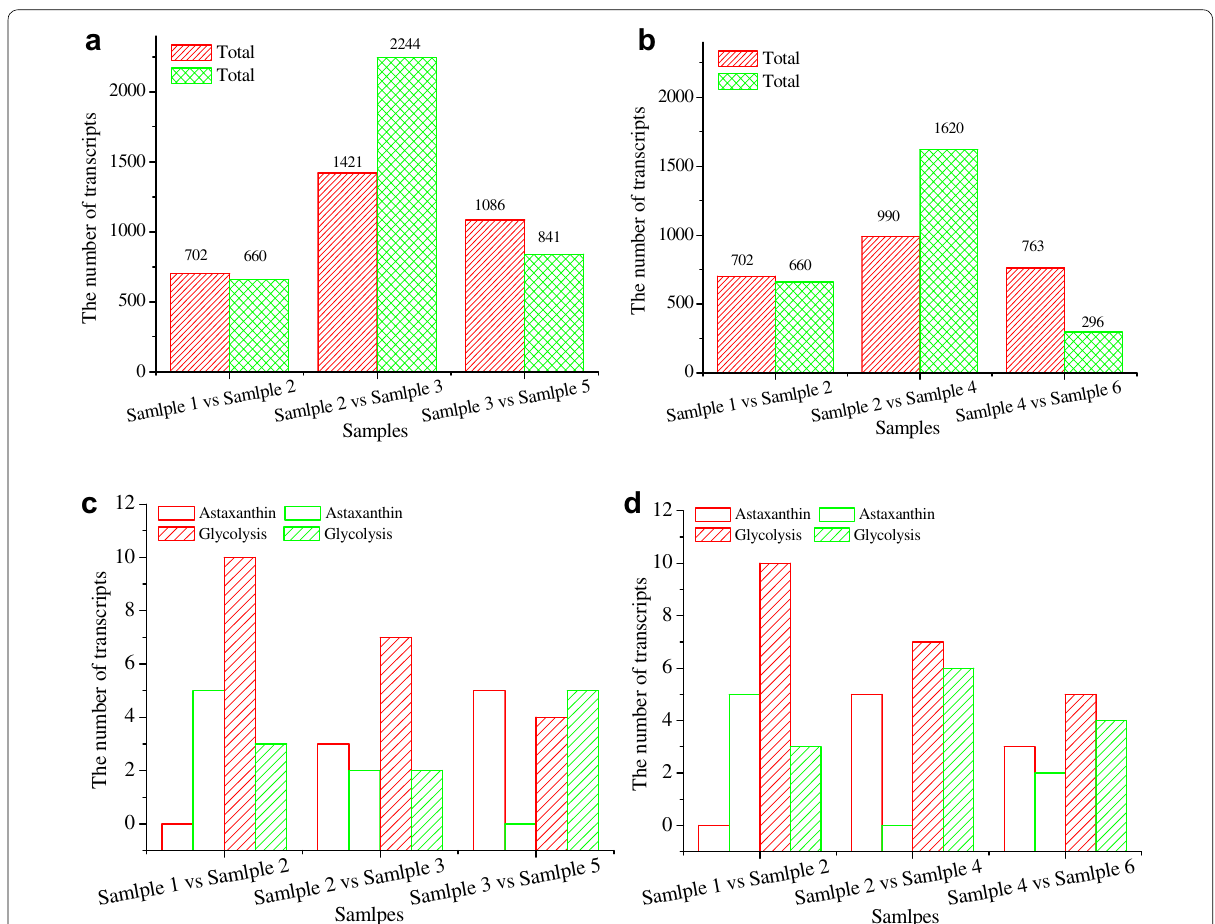
Fig. 3 Transcription amounts of up/down-regulation genes at different time points. a , b represent the number of total genes in control group ( a , 1235 route) and treatment group ( b , 1246 route), respectively; c , d represent the number of astaxanthin genes and glycolysis genes in control group ( c ) and treatment group ( d ). Sample 1, Sample 2 and Sample 3 were the heterotrophic cells at 100 h, 250 h, and 550 h, respectively; Sample 4 was Sample 2 cells induction for 0.5 day; Sample 5 was Sample 3 cells induction for 6 days; Sample 6 was the Sample 2 cells induction for 6 days. Red and green present up- and down-regulation genes number,